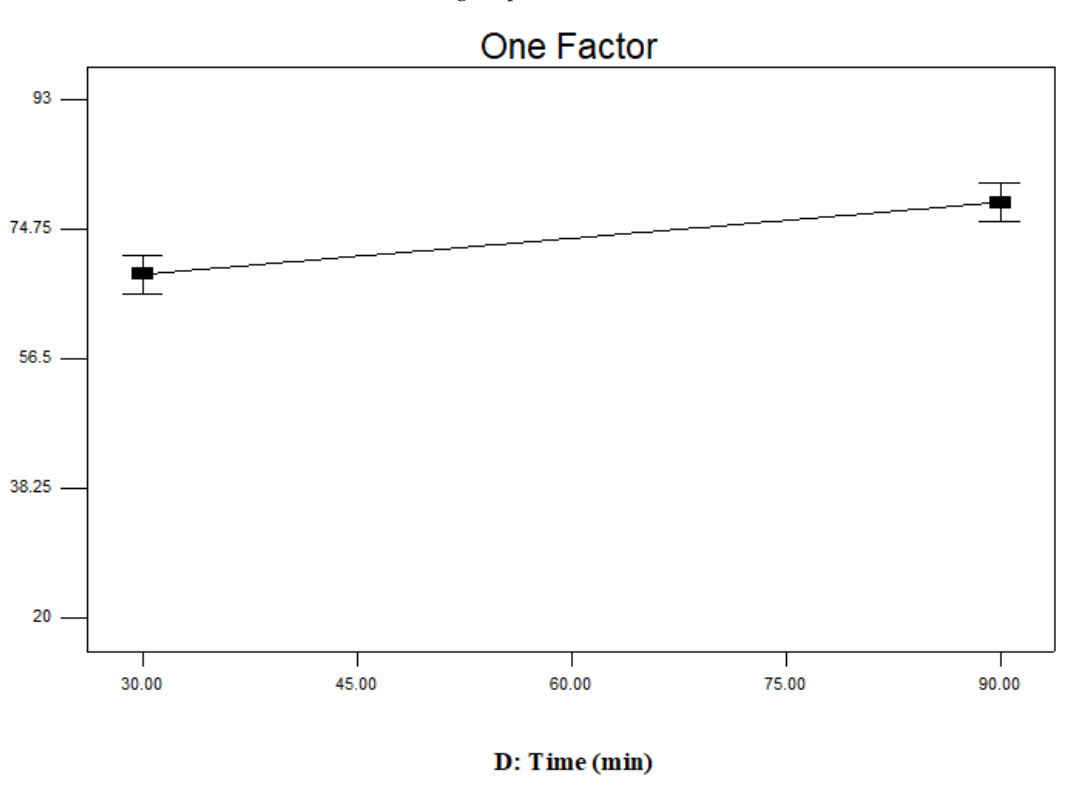
Figure 10. Effect of time on the perecentage dye removal at a constant initial dye concentration (A) 38.19 mg/L, pH (B) of nine, and adsorbent dose (C) of 200 of 38.19 mg/L, pH (B) of nine, and adsorbent dose (C) of 200 mg/L.